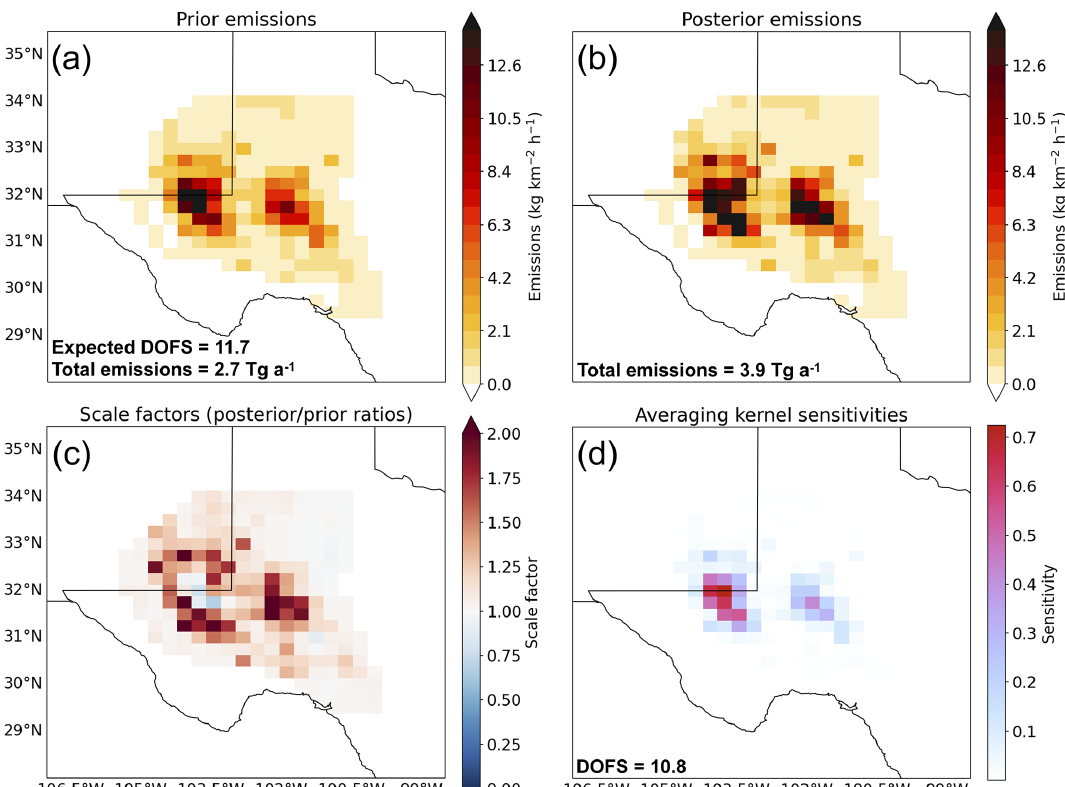
Figure 6. Results of a 1-month (1–31 May 2018) application of the IMI to the Permian Basin using the EDF emission inventory (Zhang et al., 2020) as prior estimate of emissions. (a) Prior emissions. (b) Posterior emissions. (c) Scale factors applied to the prior emissions to obtain the posterior emissions. (d) Averaging kernel sensitivities with associated degrees of freedom for signal (DOFS) inset.